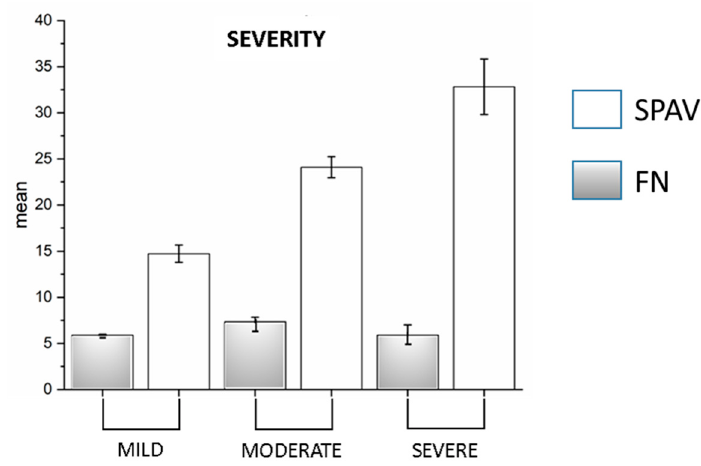
Figure 7. Superimposed graph of FN and SPAV in the three severity classes: mild, moderate, and severe. On the Y-axis are the averages of both measurements ( p = 0.001).